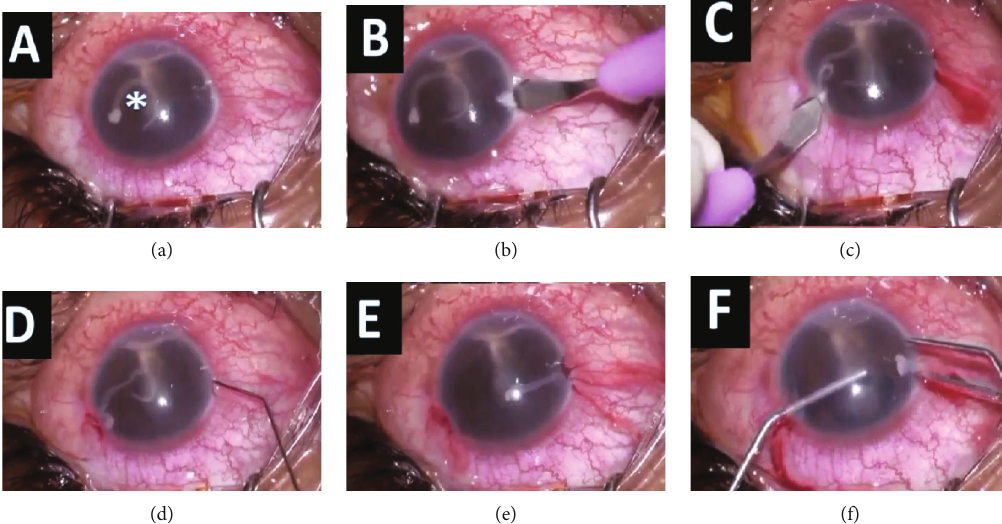
Figure 2: (a) Worm in the anterior chamber (marked with asterisk ∗ ). (b, c) Clear corneal incisions made at 9 and 2 o ’ clock. (d) Injecting pilocarpine 0.5% intracamerally. (e) Paralyzed worm which has coiled up. (f) Worm removed in toto with the use of a viscoelastic device from 2 o ’ clock port and expression from 9 o ’ clock port.